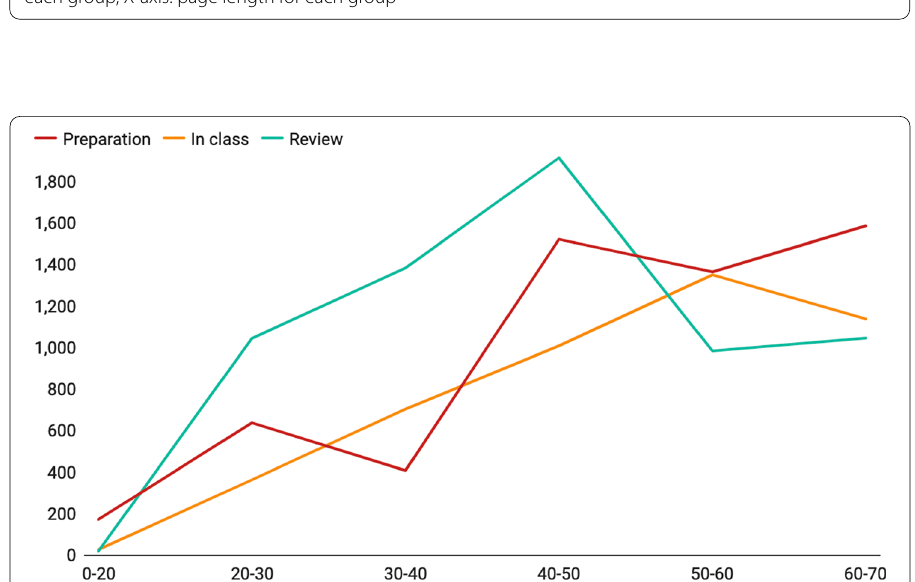
Fig. 8 Correlation between the numbers of complete-jumps and page length in different lectures. Y-axis: average number of complete-jumps of each group, X-axis: page length for each